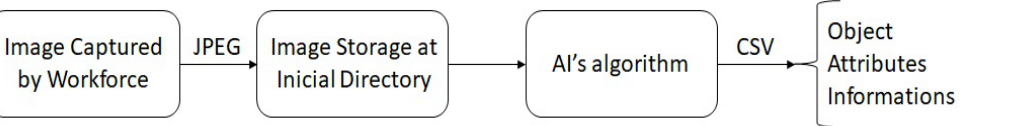
Figure 4. Image format